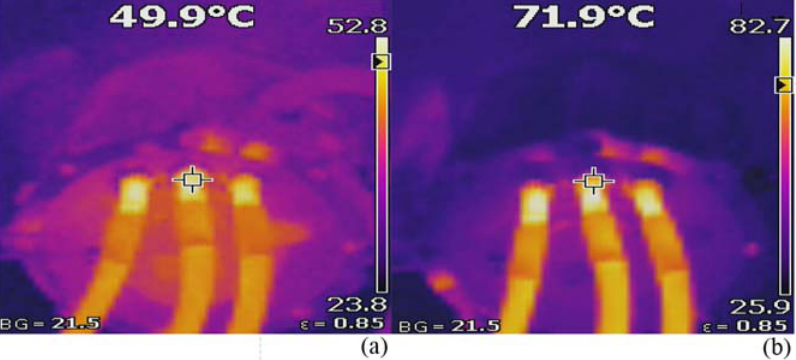
Figure 16. Infrared thermal image. ( a ) T = 119 N·m, n = 4000 rpm, I a = 151 A, ( b ) T = 295 N·m, n = 2000 rpm, I a = 351 A.